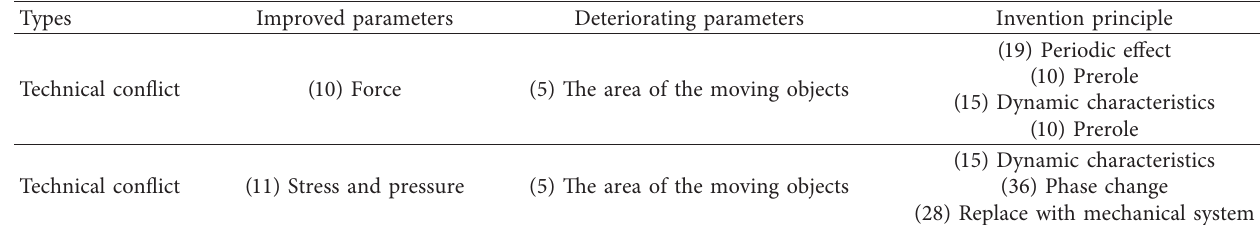
Table 3: Hard-rock sampler drilling conflict